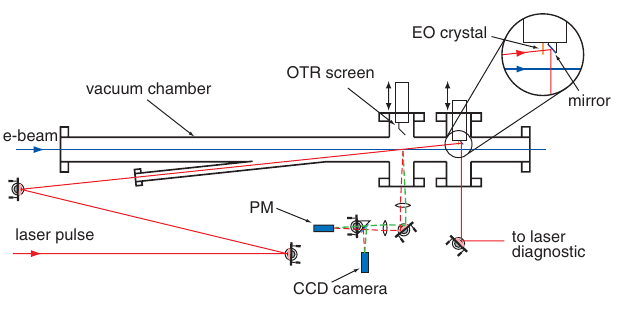
FIG. 7. (Color) The vacuum chamber of the EO setup in the accelerator tunnel. The EO crystal is positioned at a few mm distance from the electron beam. The laser beam is injected at an angle of 6 (cid:3) with respect to the electron beam, passes through the EO crystal, and is reflected out of the vacuum chamber by a small mirror behind the EO crystal. A metalized mirror can be moved into the electron beam in front of the EO crystal. By simultaneous detection of the optical transition radiation (OTR) pulses, produced by the short electron bunches, and the laser pulses with a photomultiplier (PM), the temporal coincidence of laser pulse and electron bunch can established with an accuracy of < 500 ps .